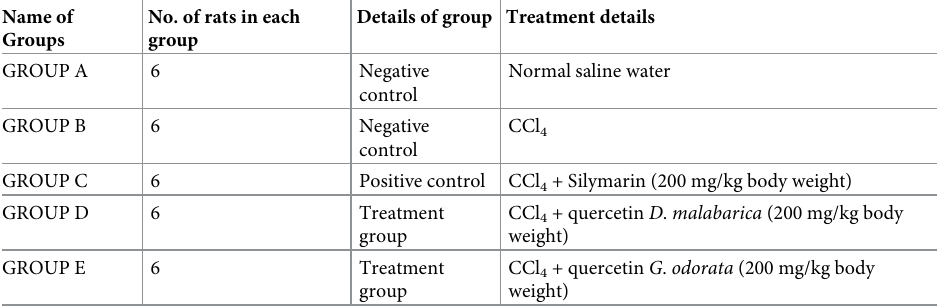
Table 1. Experimental design in five different groups of rats including control, silymarin and plant extracts of D . malabarica and G . odorata